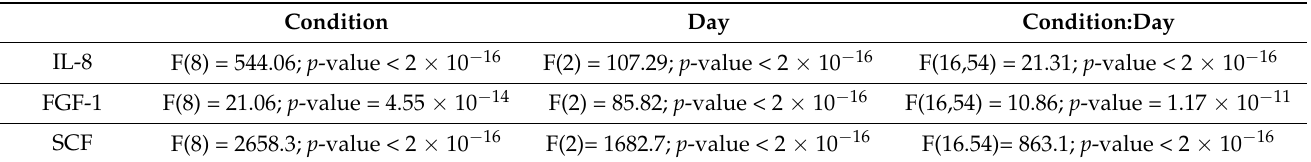
Table 4. Test statistics for Two-Way ANOVA testing for ELISA data.